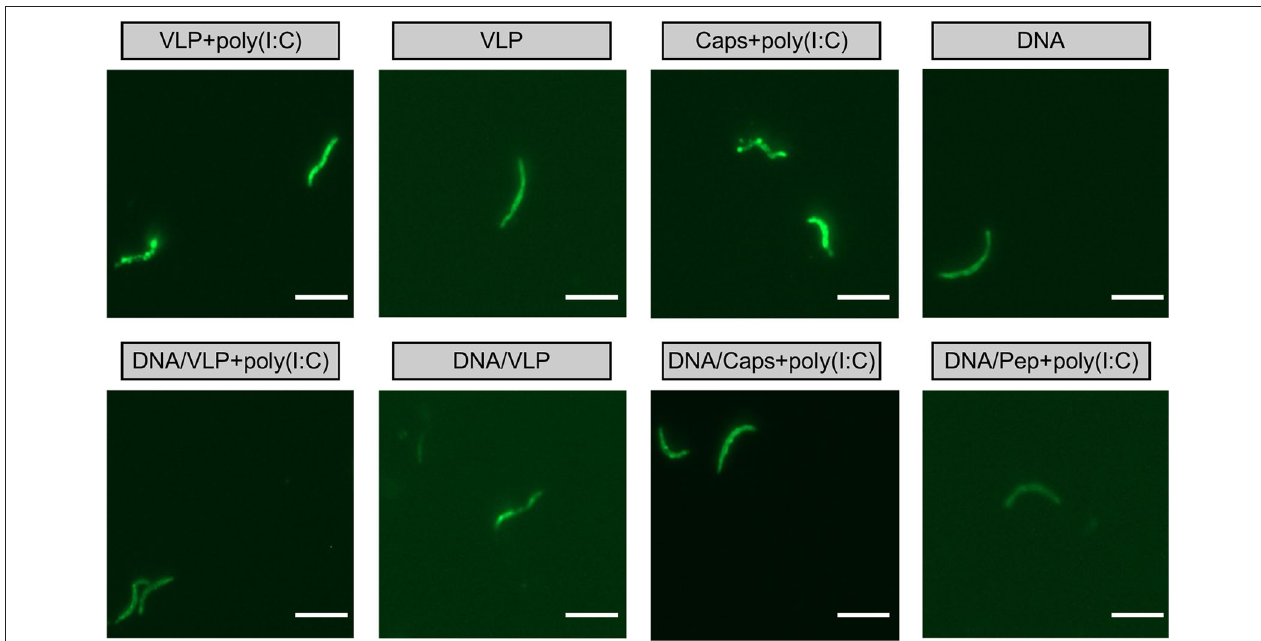
FIGURE 5 | IFAT detection of anti-sporozoite antibodies induced by immunization with chimeric VLPs or capsomeres. Mice ( n = 10/group) were immunized using a three-dose regimen with either homologous VLPs, capsomeres or Py CSP plasmid DNA; or a heterologous regimen with two Py CSP plasmid DNA doses followed by a single VLP or capsomere boost as described in Figure 1 . Sera collected from mice 5 days after final immunization was pooled and assayed against P. yoelii 17XNL sporozoite-coated slides (1:400 dilution). Slides were stained using FITC-conjugated anti-mouse total IgG and viewed on an EVOS fluorescence microscope at x1000 magnification. Scale bar represents 10 µ